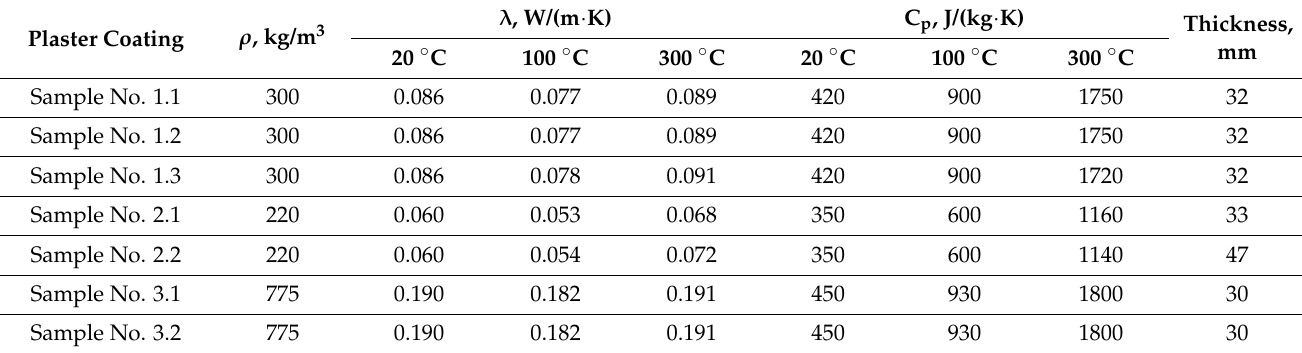
Table 3. The main characteristics of plaster